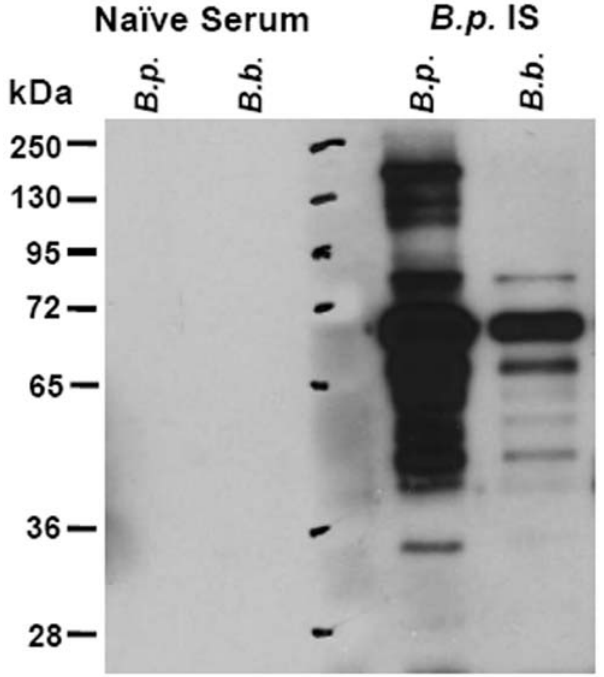
Figure 5. Analysis of cross-reacting antigens between B. pertussis and B. bronchiseptica . Lysates of B. pertussis ( B.p. ) or B. bronchiseptica ( B.b. ) were loaded in the indicated wells and separated by SDS-PAGE gel. Proteins were transferred to PVDF membrane, and then probed with naı¨ve serum or B. pertussis -infection induced immune serum ( B.p.